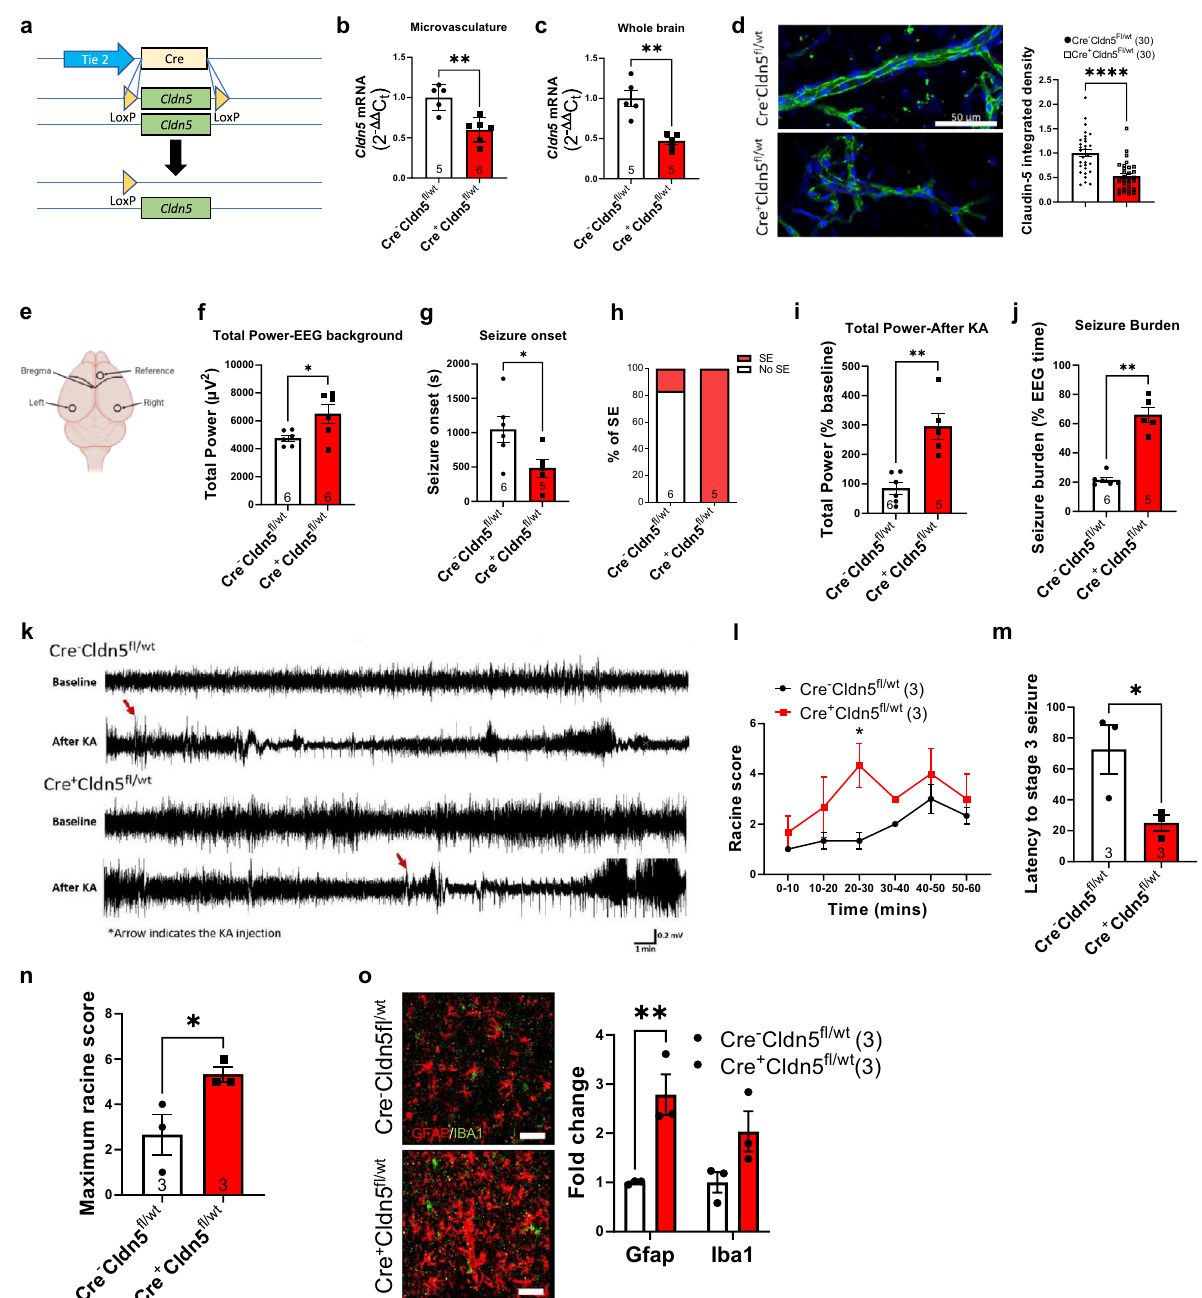
Fig. 3 Cldn5 heterozygous mice have reduced threshold for kainic acid-evoked seizures. a Schematic overview of Cldn5 fl /wt mouse. b Cldn5 transcript levels were signi fi cantly decreased Cre + Cldn5 fl /wt mice in isolated microvasculature (** p = 0.0023) and c whole brain (** p = 0.0014). d Claudin-5 protein expression signi fi cantly decreased in isolated microvessels of Cre + Cldn5 fl /wt mice (**** p < 0.0001). Scale bar, 50 µ m. e Schematic representation of electrode placement for electroencephalography (EEG) studies (top). f Increased total power in Cre + Cldn5 fl /wt mice prior to kainic acid (KA) injection (* p = 0.0311). g Reduced latency to the fi rst electrographic seizure (* p = 0.0432) in Cre + Cldn5 fl /wt mice. h Percentage of mice entering status epilepticus (SE) following kainic acid injection. i Increased total power in Cre + Cldn5 fl /wt mice following mildly convulsant KA injection (** p = 0.0015). j Increased seizure burden in Cre + Cldn5 fl /wt mice following KA injection (** p = 0.0043). k Representative EEG recording post mildly convulsive KA injection. l Increased Racine score over time in Cre + Cldn5 fl /wt mice (* p = 0.0148 at 20 – 30 min post KA injection). m Decreased latency to stage 3 seizures in Cre + Cldn5 fl /wt mice (* = 0.0459). n Increased racine score in Cre + Cldn5 fl /wt mice post injection of KA (* p = 0.0474). o Increased GFAP (red) expression in Cre + Cldn5 fl /wt mice (** p = 0.0072). IBA1 (green) expression did not change ( p = 0.0894). Scale bars, 50 μ m. Data represent means ± s.e.m.; each data point represents one animal or vessel. Number of animals ( n ) is indicated on graphs. Two-way ANOVA followed by Bonferroni ’ s multiple comparison test for Racine score over time; two-sided Mann – Whitney test for seizure burden; two-sided unpaired t -test for all other graphs. * p < 0.05; ** p < 0.01; **** p < 0.0001. Source data are provided as a Source Data fi